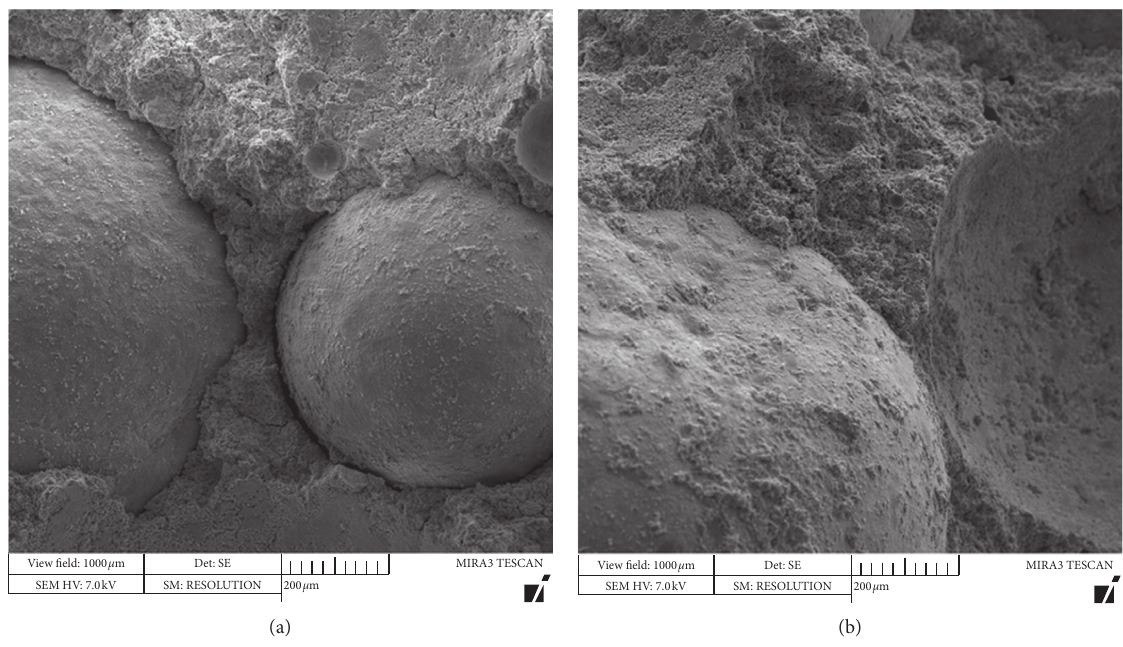
Figure 7: Surface microstructure (SEM) of a fracture of a cement composite chip based on unmodified (a) and modified (b) shot of titanium hydride subjected to c -irradiation, at a dose D � 2MGy.